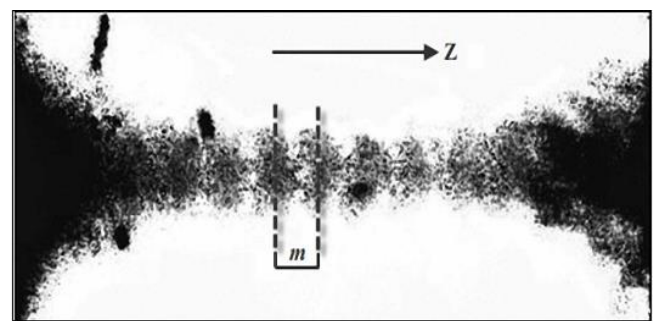
Figure 21. The discontinuous structure of a focused laser beam (λ = 514.5 nm) in a SLN single crystal. The laser beam is directed along the polar axis of the crystal; period m ≈ 0.33 mm. Extra bands with frequencies 209, 230, 298 cm − 1 are observed only in Raman spectra of heavily doped crystals LiNbO 3 : Zn (4.5 mol.% ZnO), LiNbO 3 :Mg:Fe (5.01; 0.005), LiNbO 3 : Mg (5.1), LiNbO 3 : Mg (5.3 mol.% MgO), ( Figures 14 and 18a). Their intensity depends on the crystal composition and